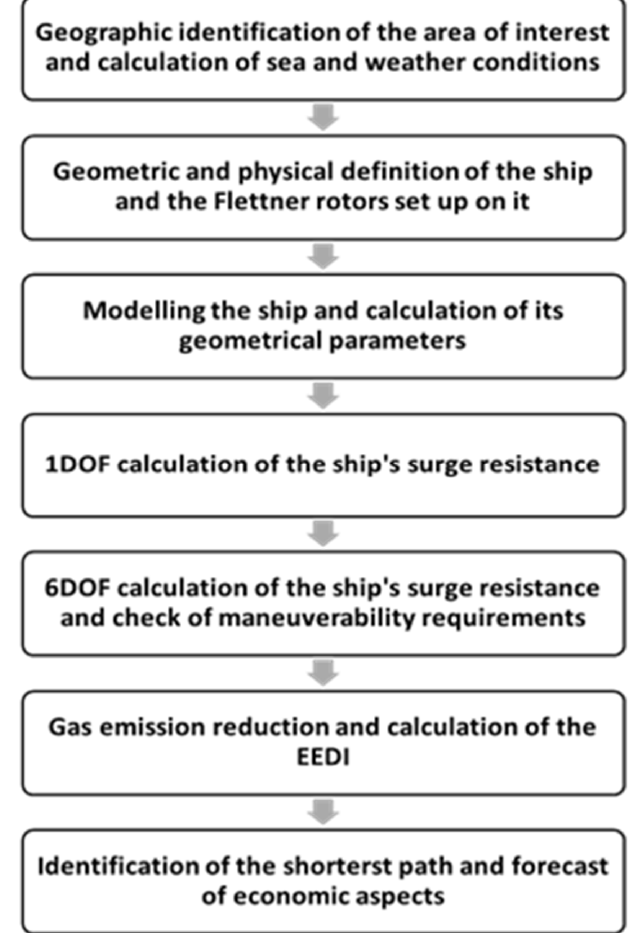
Figure 1. Code flow chart.